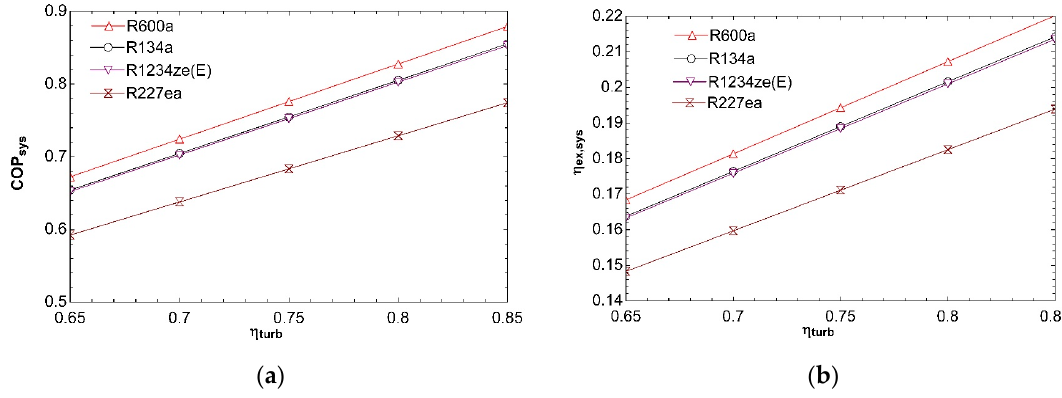
Figure 8. Influence of η turb on COP sys ( a ) and ƞ ex,sys ( b ) in combined ORC-single evaporator VCR cycle. Figure 9 indicates e ff ect of ambient temperature on coe ffi cient of performance of system.